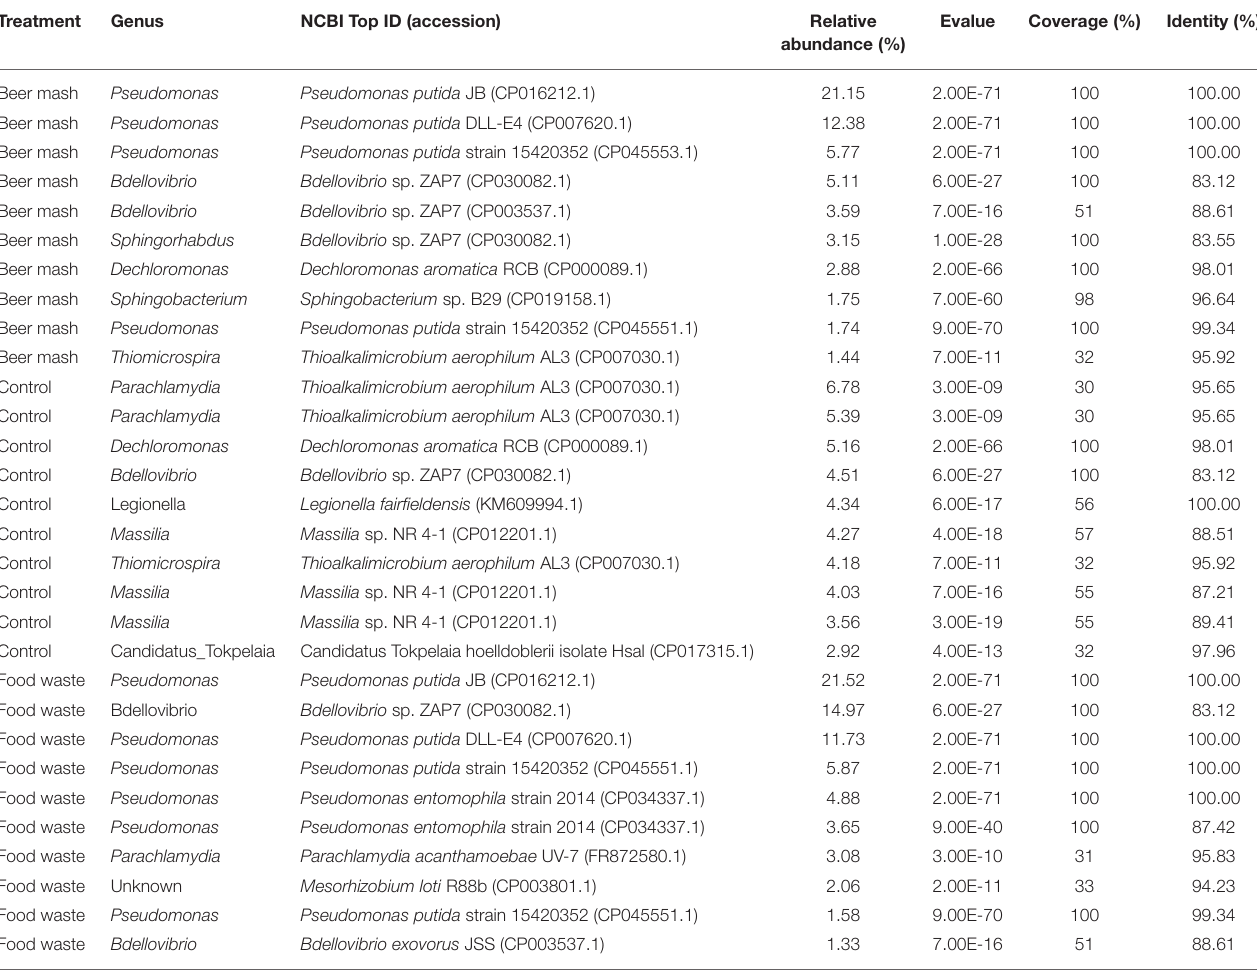
TABLE 3 | Top 10 most abundant bacterial species identified in the nutrient solution by NGS of ITS rRNA encoding region.